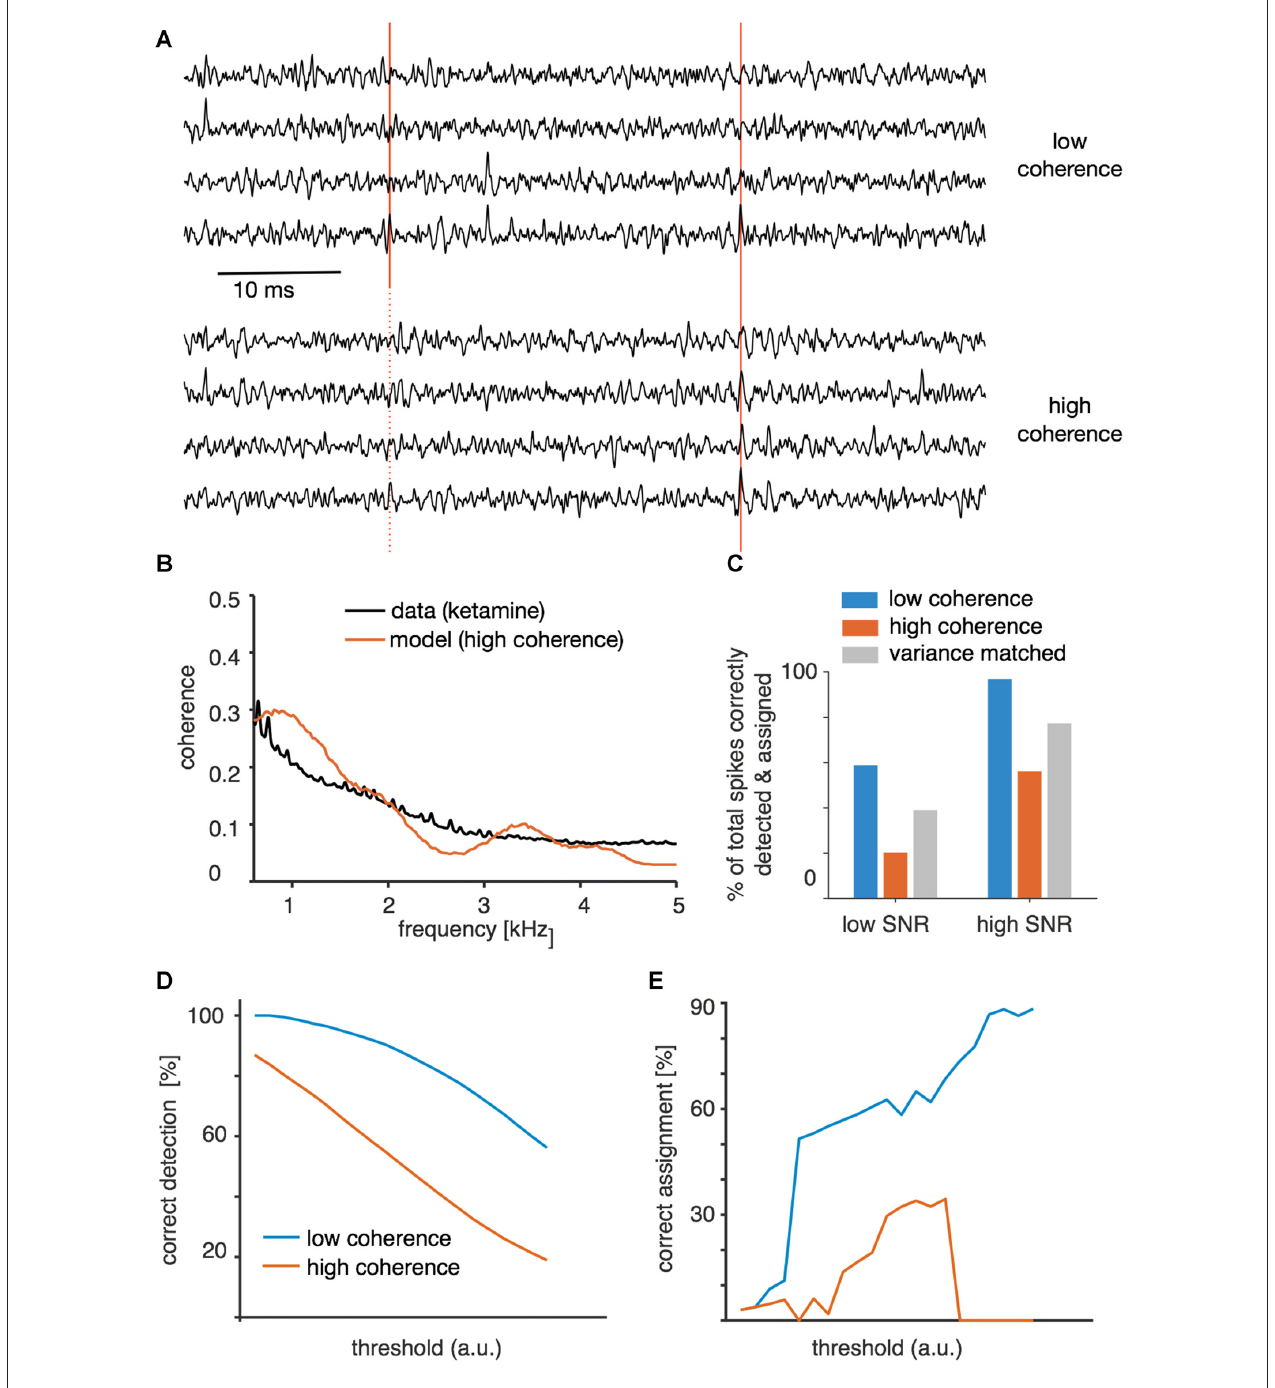
FIGURE 6 | Spike sorting of synthetic data. (A) Example traces from the low signal-to-noise ratio (SNR) condition for high and low global coherence backgrounds, including one foreground spike correctly identified in both backgrounds (solid red lines) and one spike that was detected in the control, low-coherence background but missed in the high-coherence background (dotted red line). (B) Modulation of background activity was adjusted to match local coherence observed in the real data obtained under ketamine anesthesia. (C) Spike-sorting success at low and high SNR (mean spike amplitude relative to background variance). The proportion indicated is the overall success rate for correctly assigning the originally entered foreground spikes, and is thus a result of both detection and correct clustering. For each spike-to-background SNR level, synthetic data were generated with either low coherence, high coherence, or high coherence but with variance matched to the low-coherence case. (D) Success of event detection for different threshold values for the low SNR case for both high- and low-coherence backgrounds. (E) Success of correctly assigning successfully detected events.